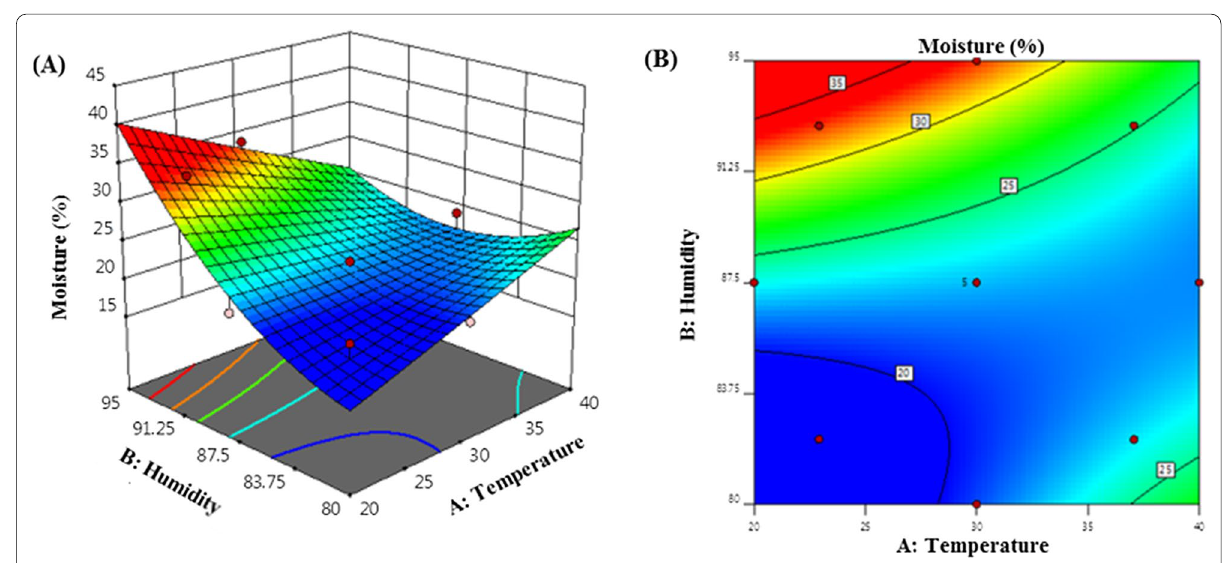
Fig. 3 Response surface model for